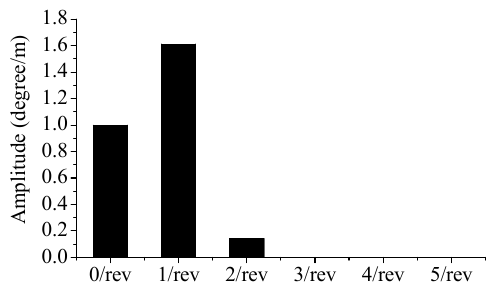
Figure 16. Amplitudes of the 0~5/rev harmonic component of the optimal input for condition B.